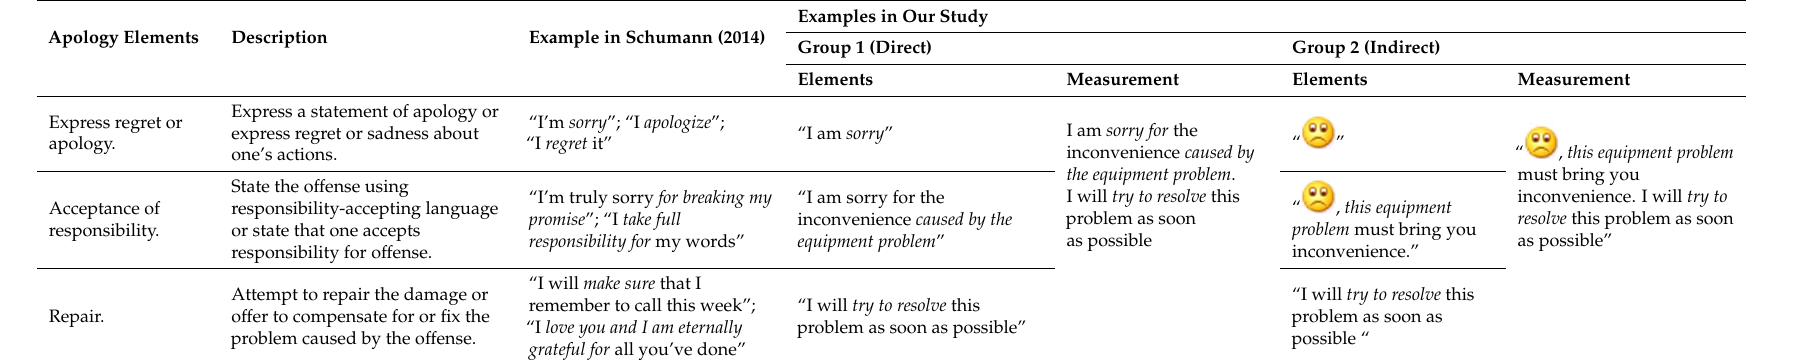
Table 2. The sample of the different expressions of apology.